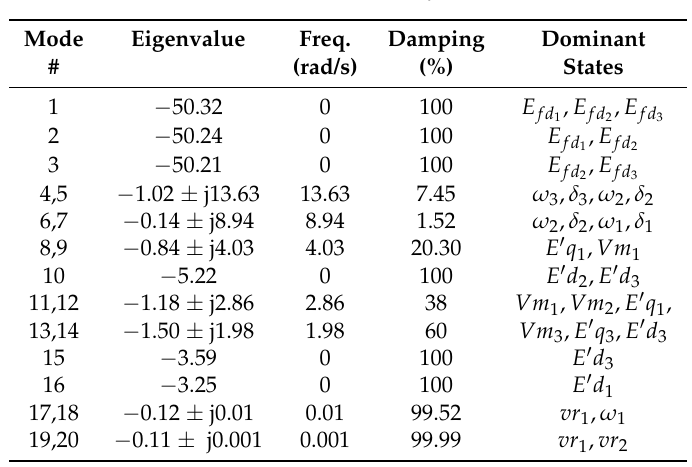
Figure 1. IEEE 9-Bus System. Table 1. Linear